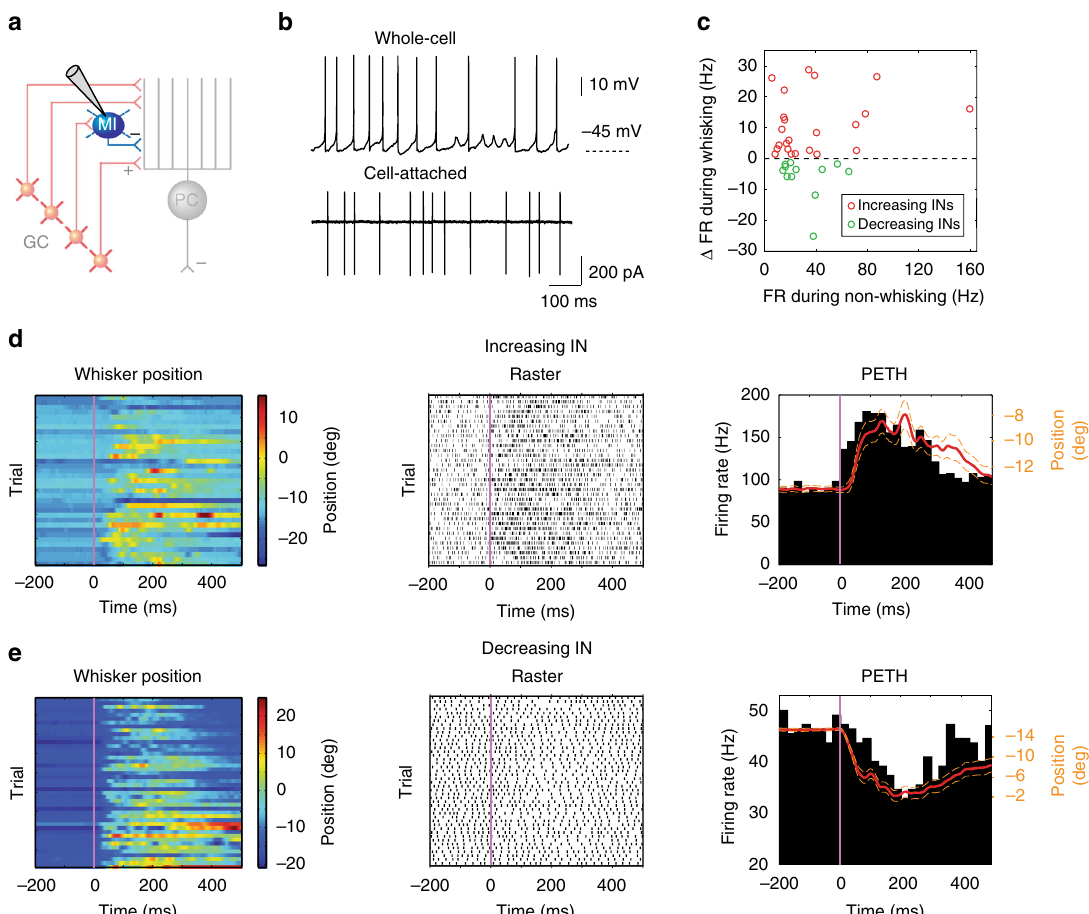
Fig. 6 Firing rate alteration of inhibitory interneurons during whisking. a Schematic representation of cerebellar circuit highlighting inhibitory interneurons (INs) in the molecular layer. b Representative whole-cell and cell-attached recordings from INs. c Relative fi ring rate change during whisking with respect to baseline rate during non-whisking for all signi fi cantly modulated INs ( P < 0.05, Wilcoxon signed-rank test, n = 35). Red and green circles represent increasing ( n = 23) and decreasing ( n = 12) cells, respectively. d IN exhibiting increasing fi ring rates during whisking. Colour-coded whisker movement ( left ) and the corresponding spike raster plot ( middle ). PETH from the same IN was overlaid with the mean whisker position ( red ; dashed orange lines : S.E.M) to show the close relationship between fi ring rate change and movement ( right ). e IN exhibiting decreasing fi ring rates during whisking. Colour-coded whisker movement ( left ) and the corresponding spike raster plot ( middle ). PETH from the same IN was overlaid with the mean whisker position ( red ; dashed orange lines : S.E.M) to show the close relationship between fi ring rate change and movement ( right